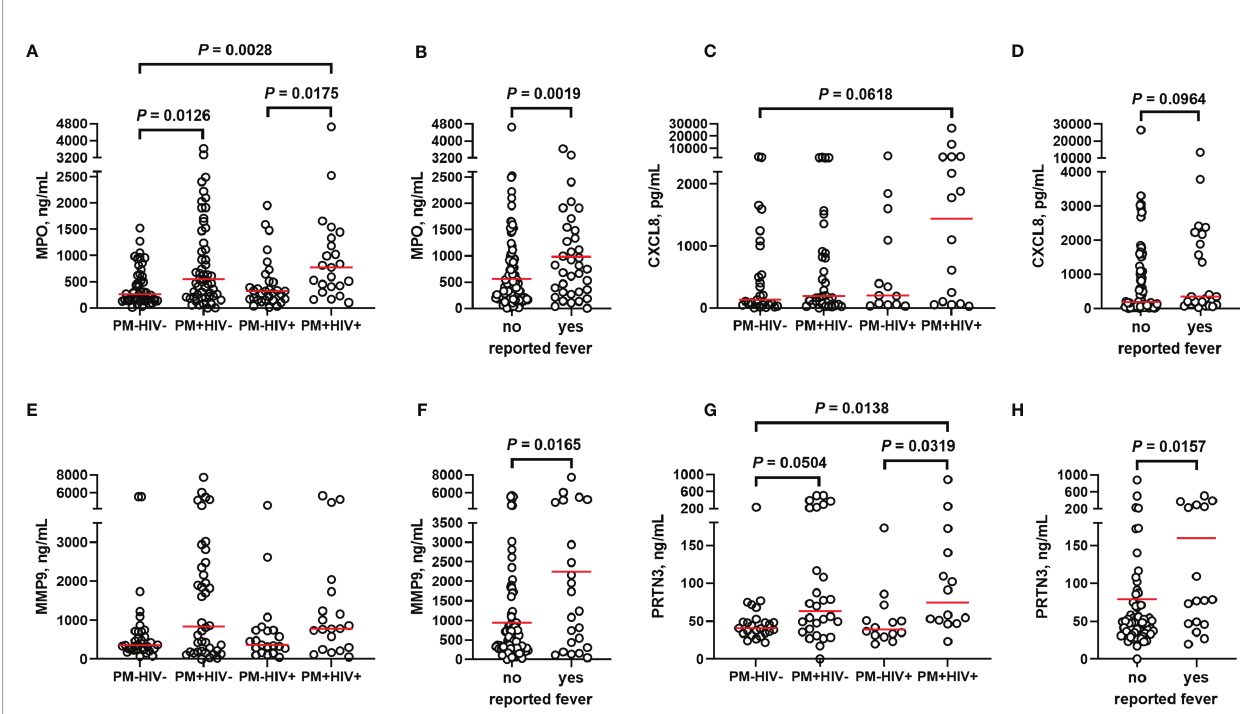
FIGURE 6 | Markers of neutrophil activation are variably altered by placental malaria and HIV seropositivity. Placental plasma from paucigravid women was analyzed for (A, B) myeloperoxidase (MPO), (C, D) CXCL8, (E, F) matrix metalloproteinase 9 (MMP9), and (G, H) proteinase 3 (PRTN3) levels by bead array and ELISA and strati fi ed by (A, C, E, G) infection status and (B, D, F, H) self-reported fever (independent of infection status). (A, C, E, G) Statistics by Kruskal-Wallis test with post- hoc group-wise comparisons by Dunn ’ s multiple comparisons test and (B, D, F, H) by Mann-Whitney U test. MPO: HIV-/PM-, n = 50; HIV-/PM+, n = 53; HIV+/PM-,